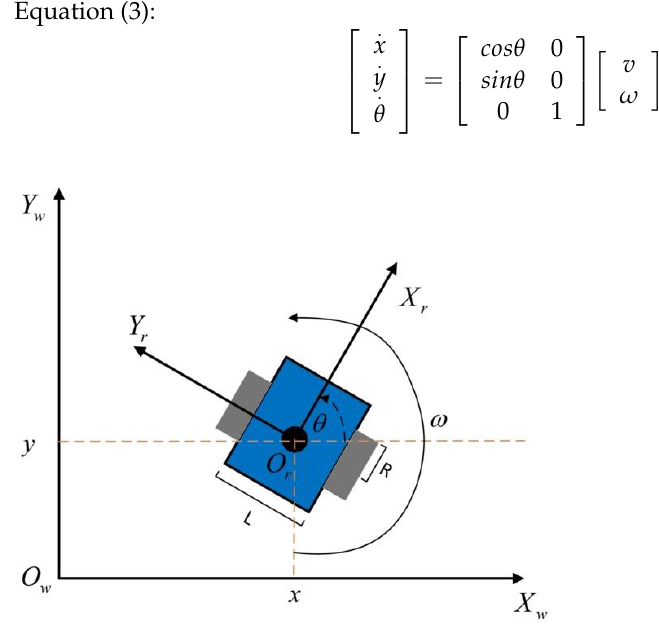
Figure 3. Schematic diagram of robot posture adjustment.